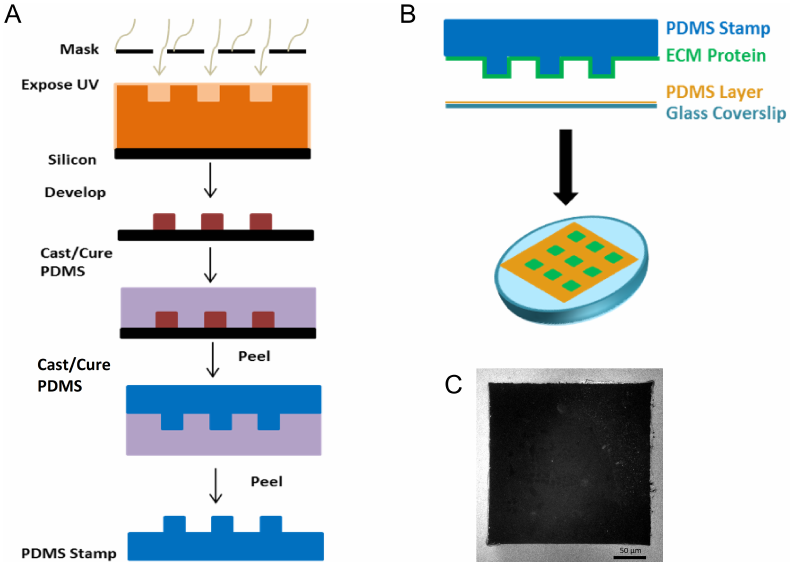
Figure 3. Fabrication of substrates to generate repeatable epithelial cell colonies. ( A ) To study this in a controlled environment, we utilized photolithography to generate stamps that con- sisted of 250 µ m × 250 µ m raised squares. ( B ) The process for microcontact printing an array of 250 µ m × 250 µ m squares onto polydimethyl-siloxane (PDMS)-coated glass. ( C ) Representa- tive immunofluorescence image of fluorescently labeled BSA (white) showing the inverse of a 250 µ m × 250 µ m square. Scale bar 50 µ m.